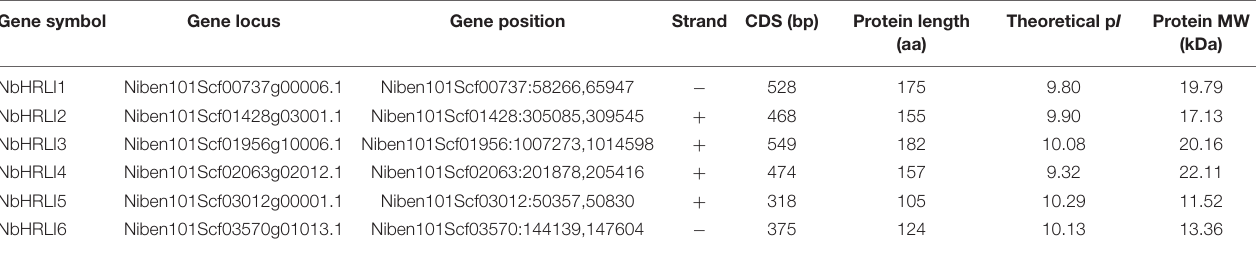
TABLE 1 | General information on HRLI members in N. benthamiana . Gene